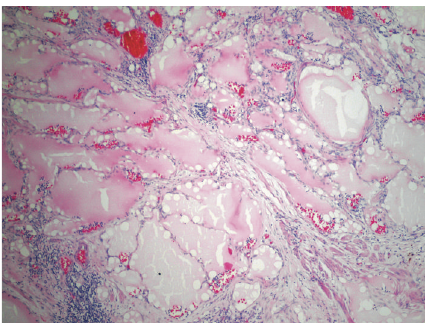
Figure 4: Histology showing a mixtureof lymph vessels and smooth muscle, with lymphatic channels containing blood and lymphoid cells (magnification × 100).